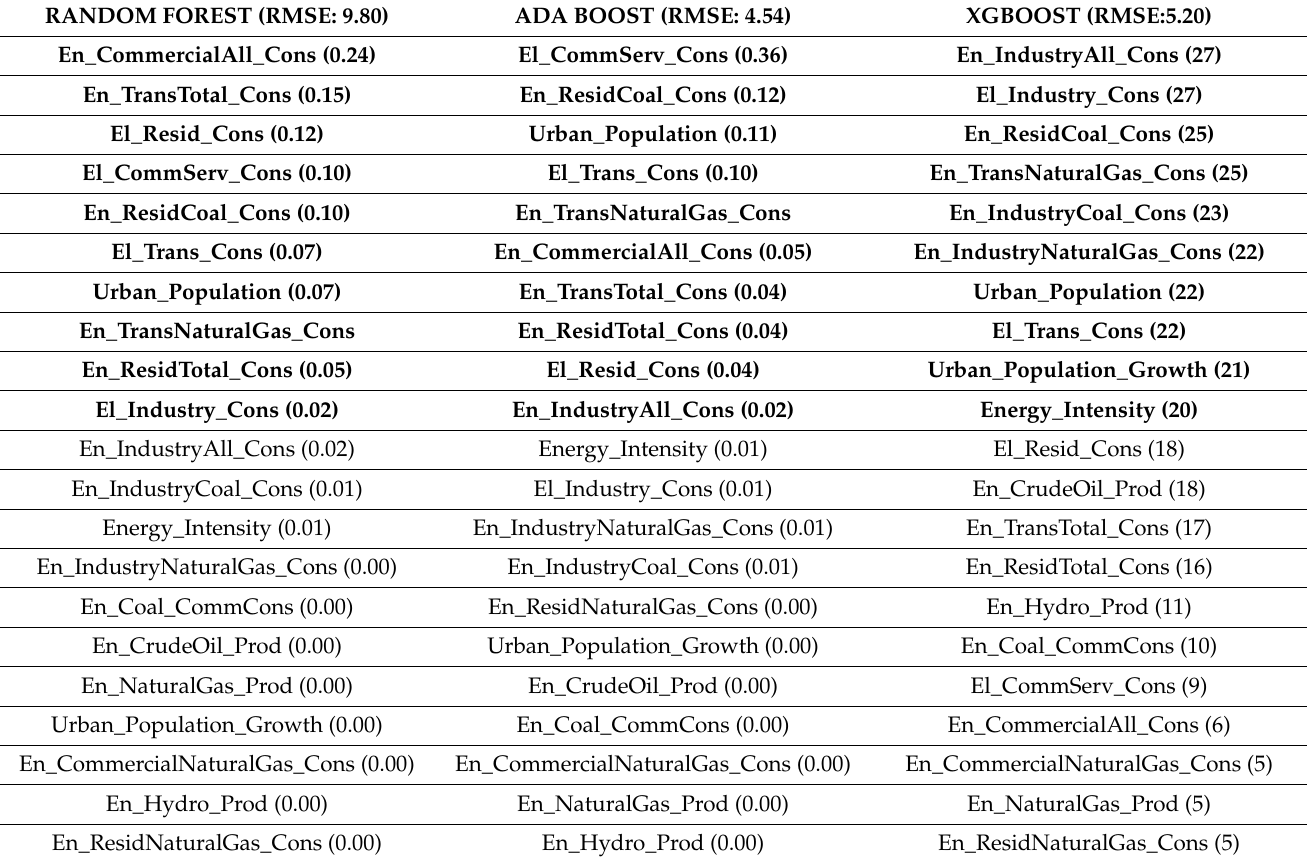
Table 2. Feature Importance (Weight Values)—Various Ensemble